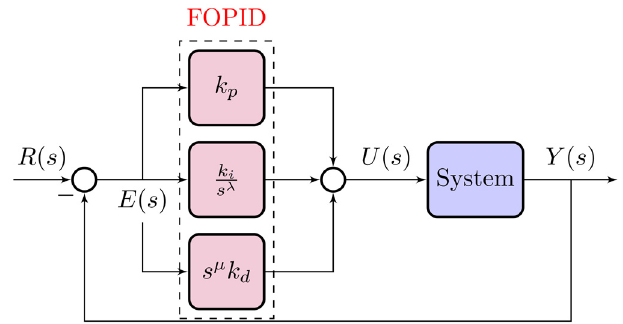
Figure 3. The basic structure of the FOPID controller.